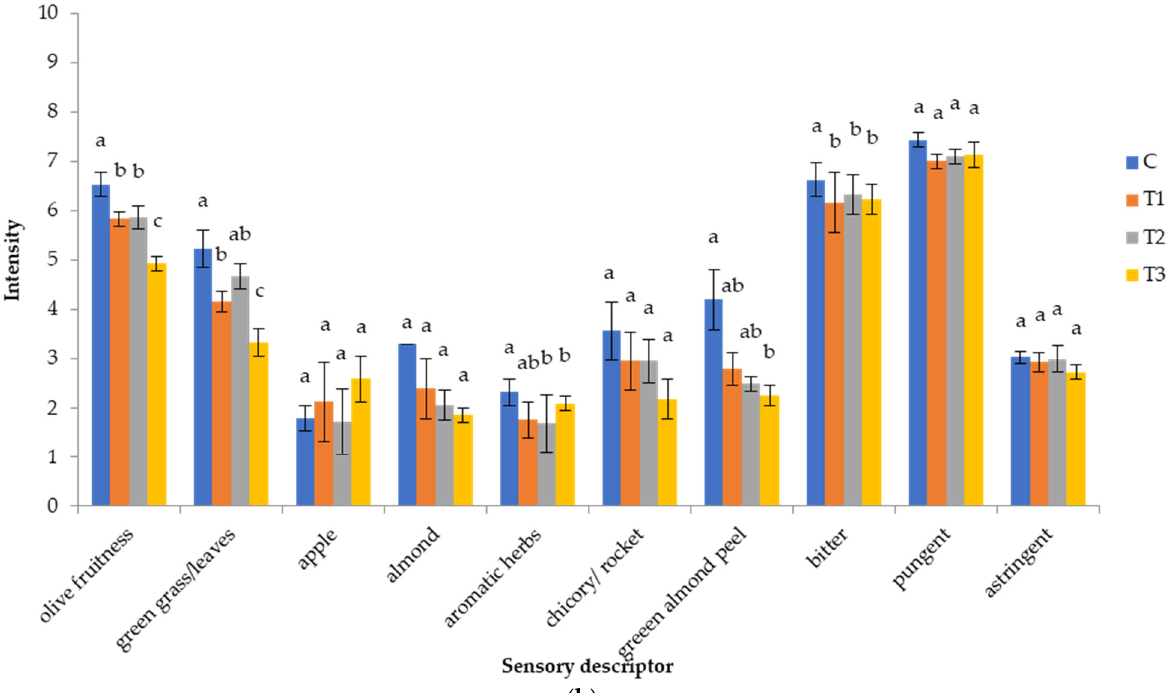
Figure 4. Sensory characteristics of virgin olive oils from Coratina cv. olive trees grown under different watering regimes during two crop seasons: ( a ) 2019 and ( b ) 2020. Watering regimes: C—rainfed conditions; T 1 —deficit irrigation (the usual producer’s practice); T 2 —deficit irrigation acquired by SAN technology in respect to phenological stages; T 3 —irrigation with 100% of evapotranspiration (ETc) level. Results are expressed as mean values ± standard deviation of three independent repetitions. Mean values labeled with different lowercase letter within the same characteristic and within the same harvesting year are statistically different (Tukey´s test, p ˂ 0.05).